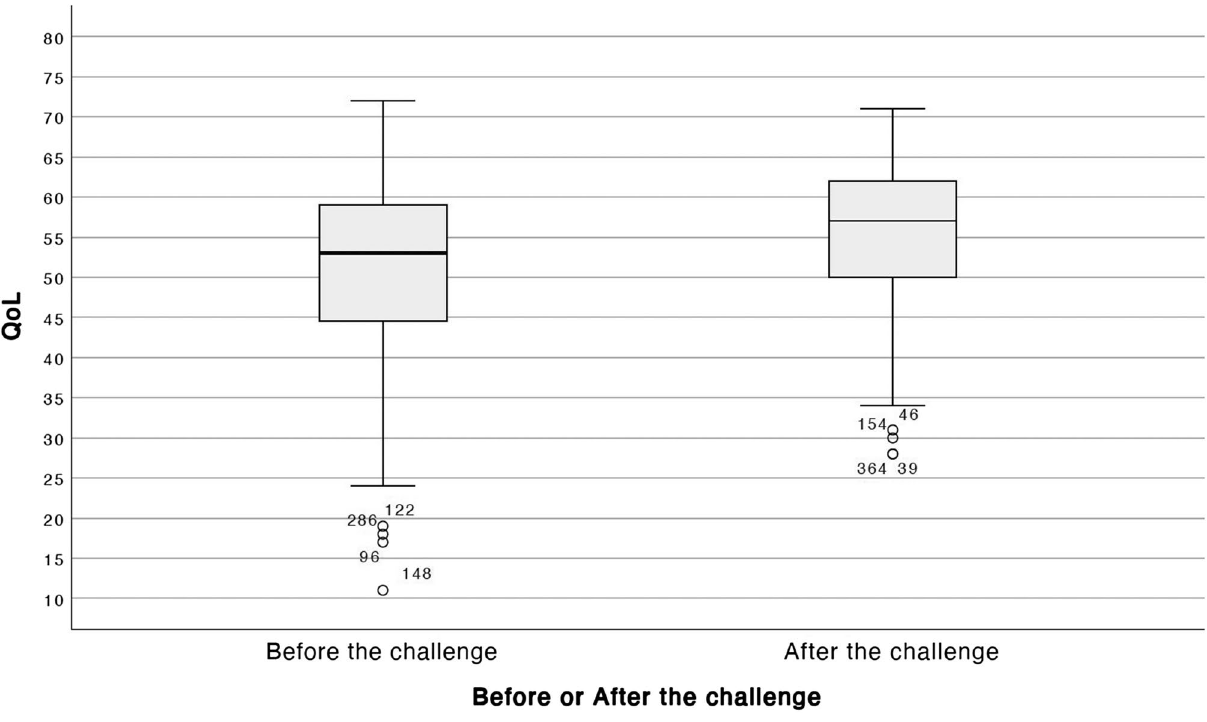
Figure.1. Overall HRQL Score Before and After the Walking Challenge.